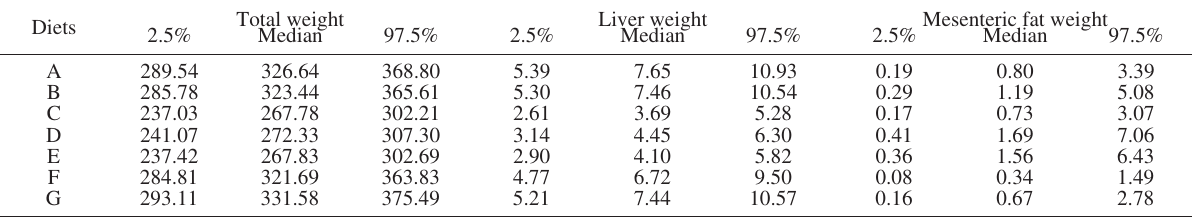
Table 4. – Summary of the weight-length analysis results for the total, liver and mesenteric fat weights of the different diets for a desired size at release of 30 cm, with the median value and lower and upper 2.5% percentiles of the Bayesian credibility intervals for the estimated weights